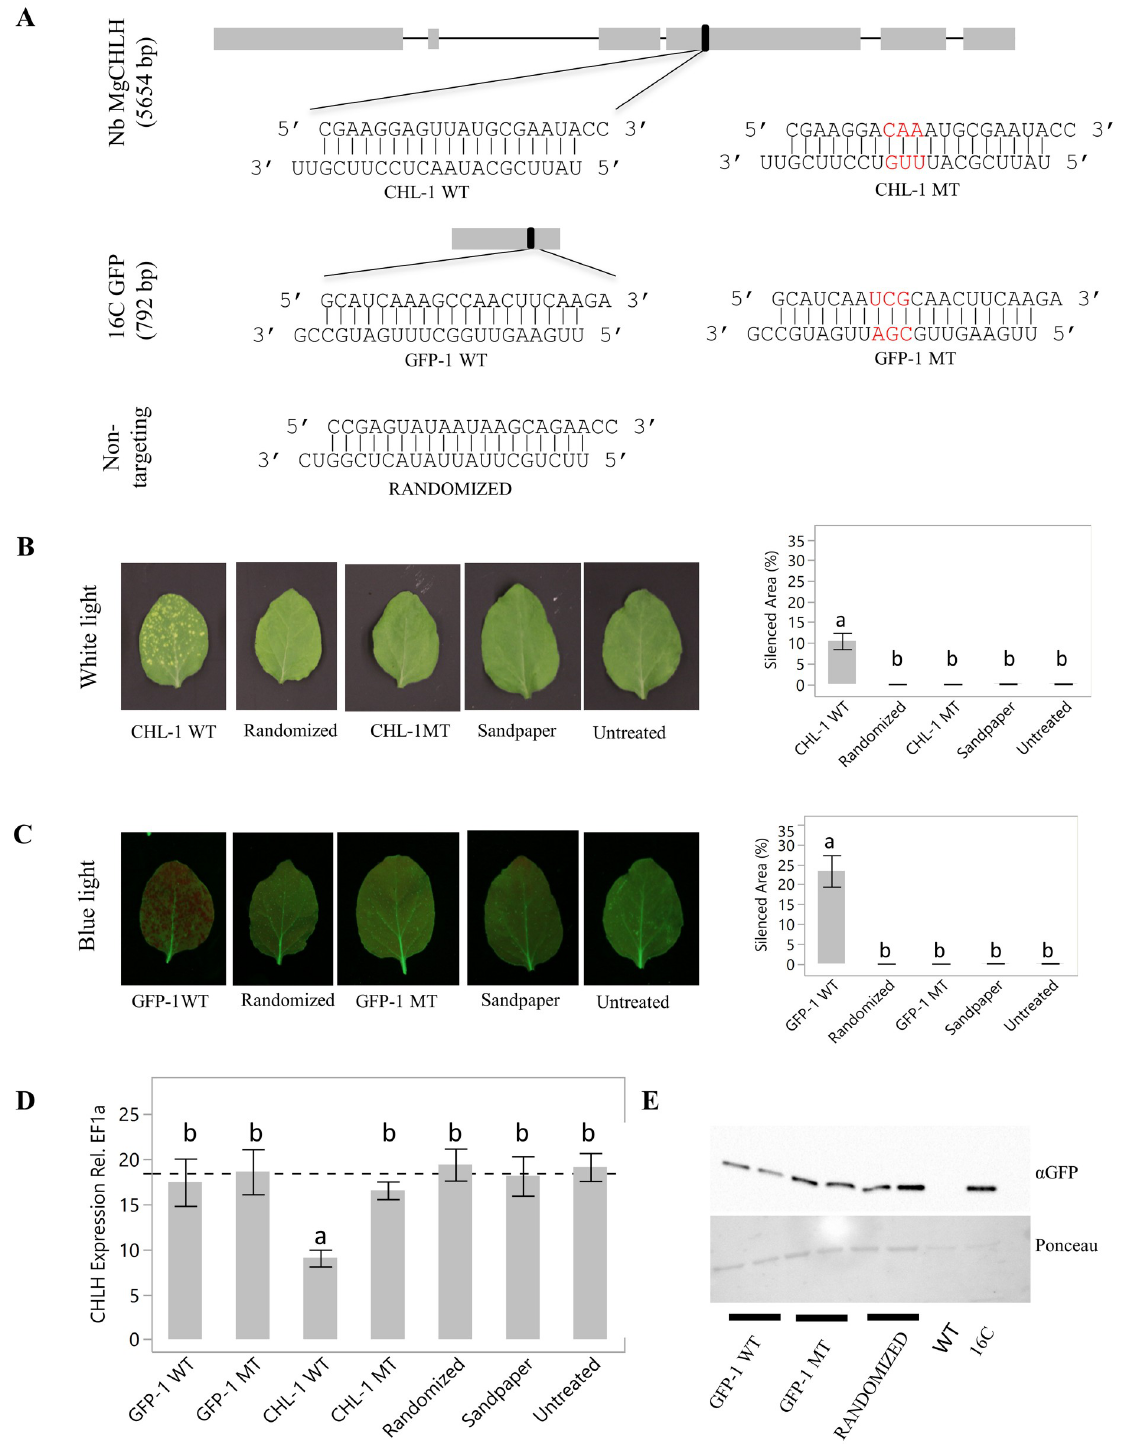
Fig 1. Sandpaper application of siRNA duplexes resulted in an RNAi phenotype. A, Location of siRNAs targeting the CHLH and GFP genomic locations in the N . benthamiana wildtype and16C lines. Boxes and lines indicate the exons and introns, respectively. The 21 bp sequences with 2 nt 3’ overhangs were tested as wild type or with mutations shown in red. The top strand is the sense sequence, and the bottom is the antisense sequence of the duplex. Leaves were treated with the indicated siRNA duplexes by sandpaper abrasion and photographed under white (B) or blue light (C) 4 dpa. The phenotypic area was quantified with Image J and was graphed as percent of the